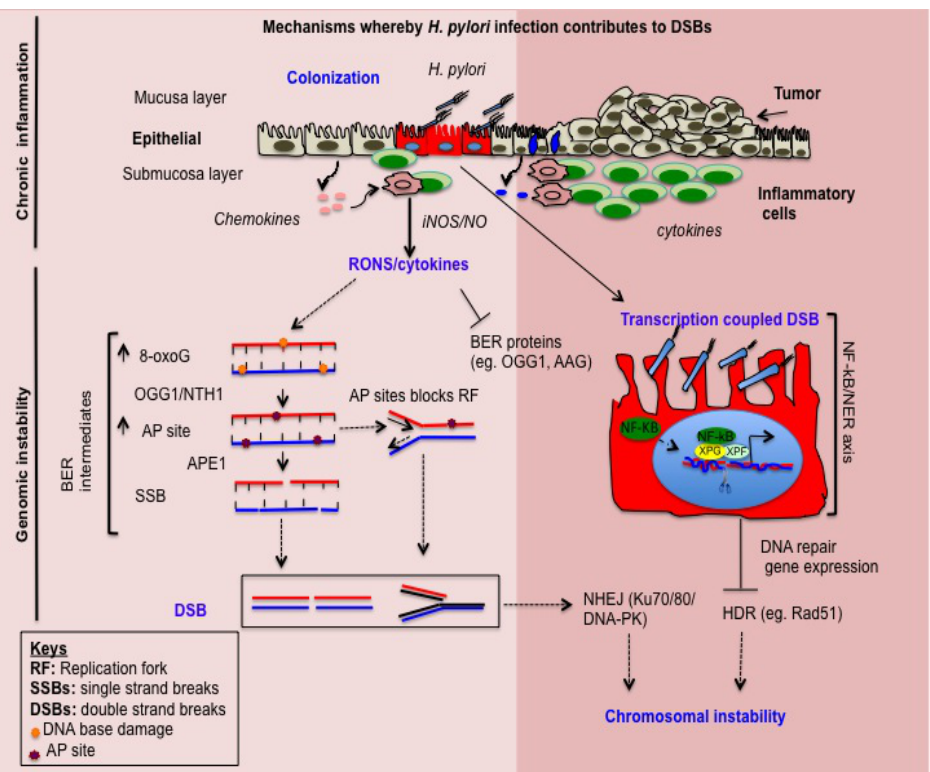
Figure 1. Molecular mechanisms of H. pylori -induced double strand breaks (DSBs). Schematic representation of how H. pylori induces DSBs. H. pylori infection causes DNA damage in gastric epithelial cells [24]. H. pylori -host cell interaction is a prerequisite for DSBs [25] (top panel). Persistence of the host-bacterium interaction leads to chronic inflammation and the release of inflammatory cytokines and chemokines, which contribute to oxidative DNA damage that is processed via base excision repair (BER) pathways (bottom panel). Processing oxidative DNA damage by DNA glycosylase (e.g., OGG1, NEIL1, etc.) contributes to accumulation of apurinic/apyrimidinic (AP) sites that are eventually converted to DSBs [26]. In addition, some cytokines (e.g., TNF- α ) inhibit BER proteins to exacerbate genomic instability. The second pathway associated with H. pylori -mediated NF- κ B activation leads to formation of a protein complex with nucleotide excision repair proteins (XPF and XPG), cleaves the promoter regions, and alters gene expression [11] including HR DNA repair proteins (Rad51). Alternatively, NF- κ B/iNOS-mediated NO production leads to DNA damage and/or inhibits DNA repair proteins (AAG) that likely impact BER and cause DSBs. Note that solid arrow and dot arrow shows activation and alternative avenue for the down stream events respectively; T bar shows inhibition or suppression of protein activity or gene